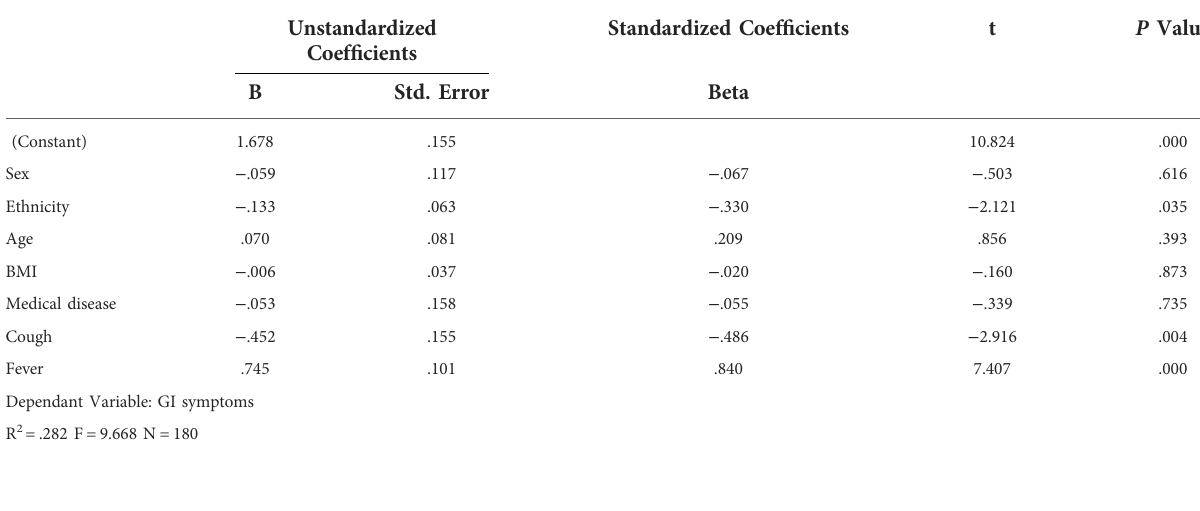
TABLE 1 Regression analysis, predisposing factors to development of GI